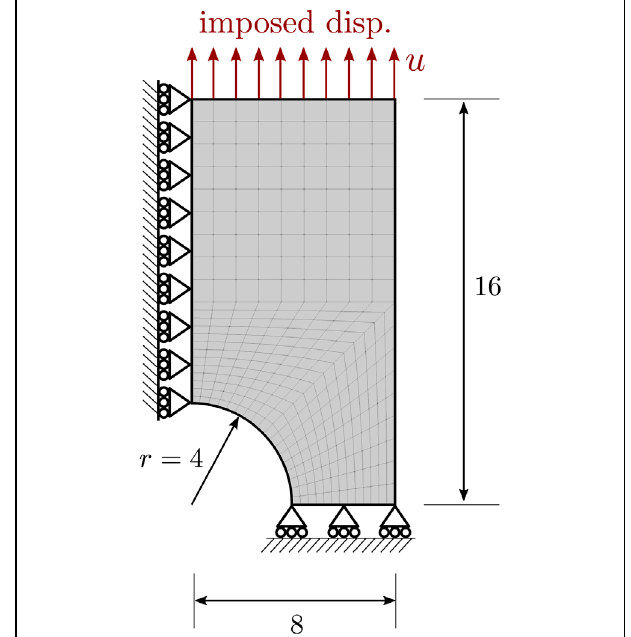
FIGURE 2 | FEM model used during virtual tests. The elements employed are quadratic quadrilateral with nine integration points.